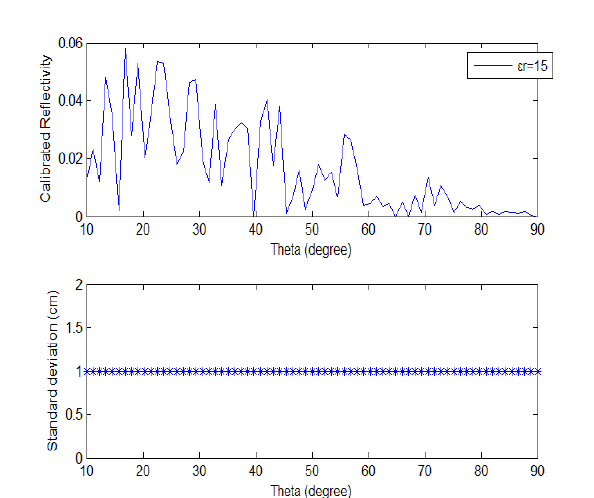
Fig. 2. The estimation of soil surface roughness for random surface